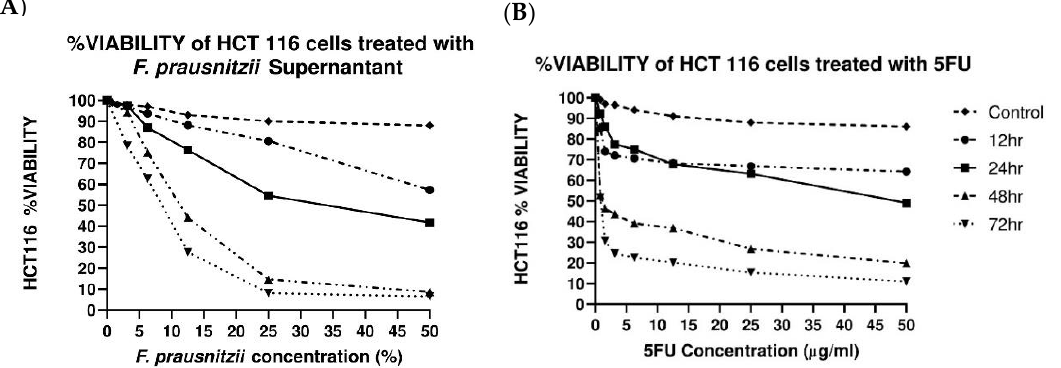
Figure 1. Cell viability of HCT116 colorectal cancer cells. Graphs shows time- and dose-dependent reduction of cell viability of HCT116 cells treated with F. prausnitzii cell-free supernatants ( A ) and 5-Fluorouracil ( B ) for 12, 24, 48, and 72 h. All values are expressed as the mean ± SEM of triplicates.